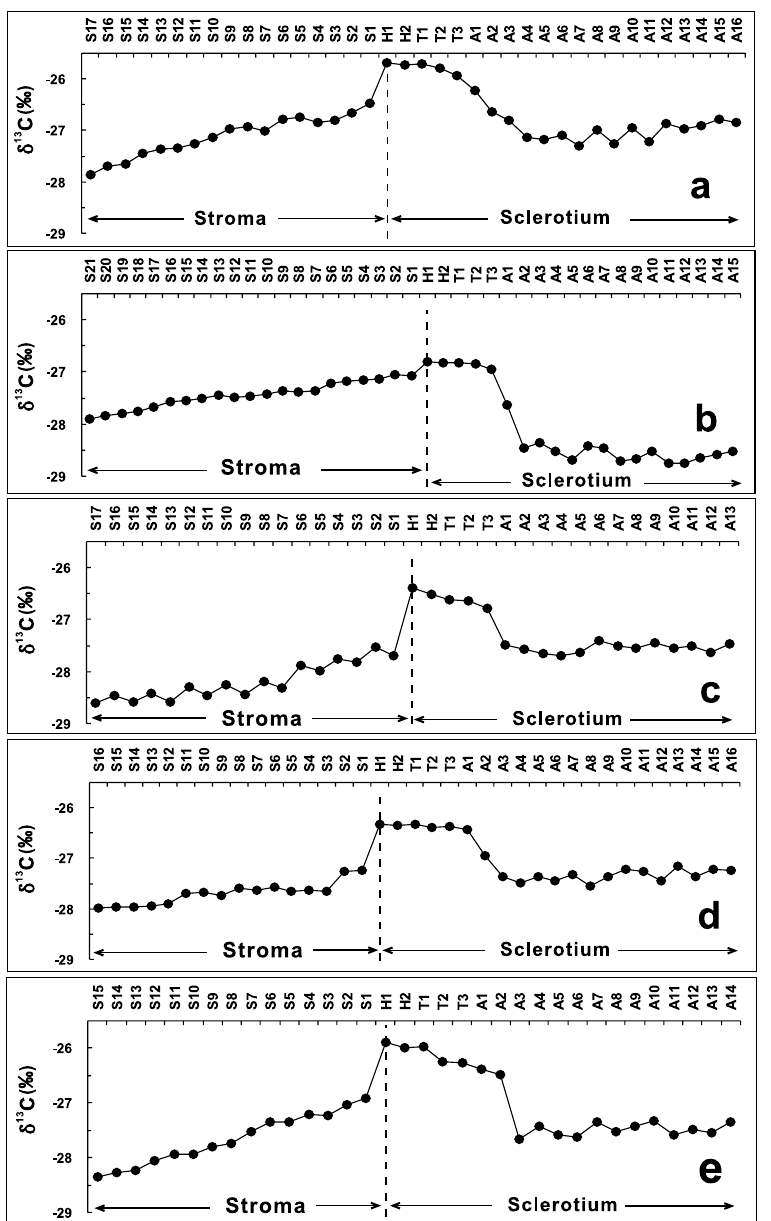
Figure 2. Variations of the δ 13 C values in the subsamples of C . sinensis . Samples ( a , b , c , d and e ) were produced from Changdu, Guoluo, Haxiu, Litang and Naqu, respectively. Each sample was sectioned into approximately 40 pieces from the stroma top to the sclerotium end. These sample sections were divided into four subsample groups according to their relative positions: stroma (S1 to S i ), head (H1 to H2), thorax (T1 to T3), and abdomen (A1 to A i